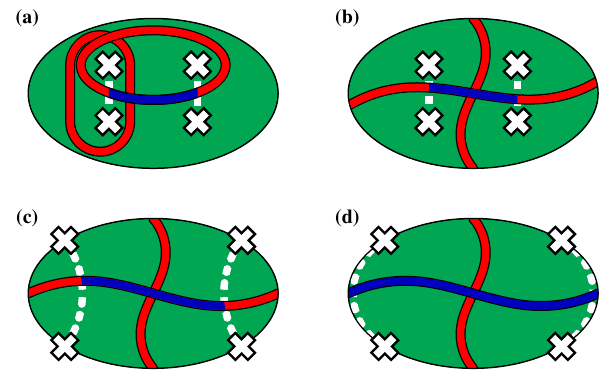
FIG. 5. Lattices with different configurations of twist defects but equivalent logical operators. (a) Four twist defects in the center of the lattice. The logical operators are closed loops that enclose pairs of twists. (b) The logical operators shown in (a) multiplied by stabilizer operators that terminate at the boundary, as in Fig. 4(c), thus giving the logical operator shown in the picture. (c) We consider the lattice shown in (a) and (b), except where the defect lines terminate at the boundary. In this picture, the twist defects lie at the boundaries of the lattice. Importantly, the logical operators are unchanged from those shown in (b). (d) We finally show the lattice where the defect lines are drawn close to the left and right sides of the lattice. Now, the logical operators are equivalent to those in Fig. 1, where a string of Pauli- X operators runs from the left to the right of the lattice and a string of Pauli- Z operators runs from the top to the bottom of the